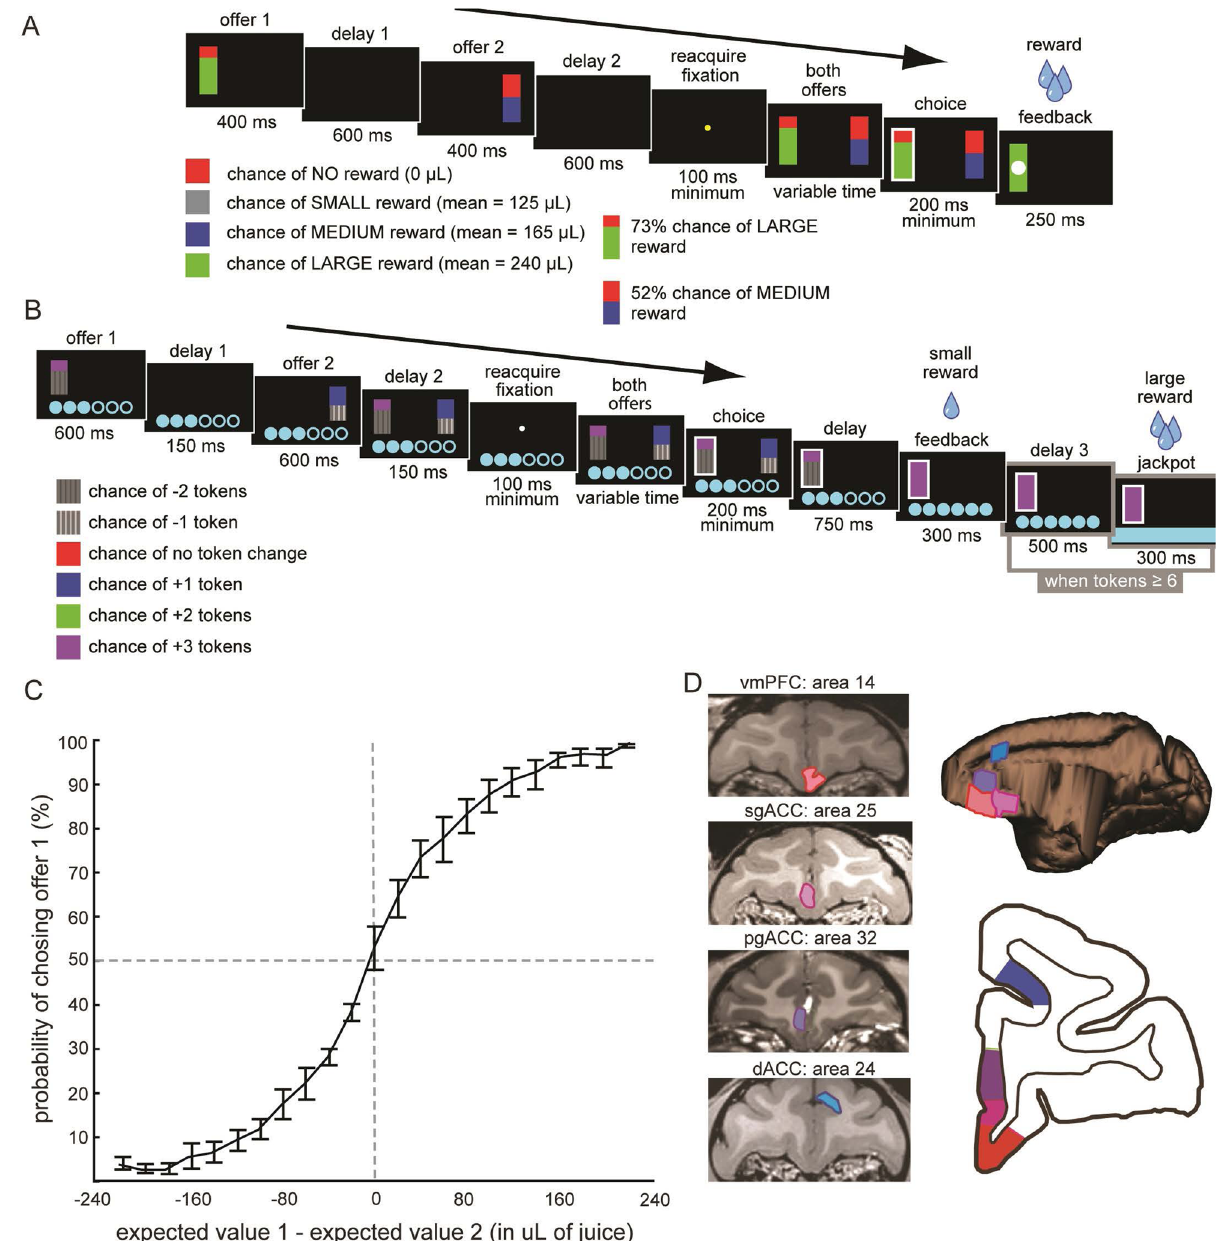
Fig. 1 Tasks, behavior, and structures. A Risky choice task: the fi rst offer is presented, followed by a delay period, after which the second offer is presented. After another delay period, fi xation is reacquired for a minimum of 100 ms. Both offers are then presented, a choice is made, and the choice is probabilistically rewarded. Offers consist of a reward magnitude (color of the non-red portion of the bar) and a probability (size of the colored portion). B Token risky choice task: equivalent format but the reward is tokenized. Once tokens reach 6, a reward is delivered. C The sigmoid is plotted along with the mean choice behavior across all subjects and recording sessions ( n = 4 animals recorded across 525 sessions). Error bars re fl ect the standard error across sessions. Source data are provided as a Source Data fi le. D MRI scans of the brain areas targeted for recordings (red = vmPFC, pink = sgACC, purple = pgACC, blue = dACC). A single representative subject is chosen for each area even though two subjects were recorded for each. The right panels denote the targeted brain areas on both transverse and coronal